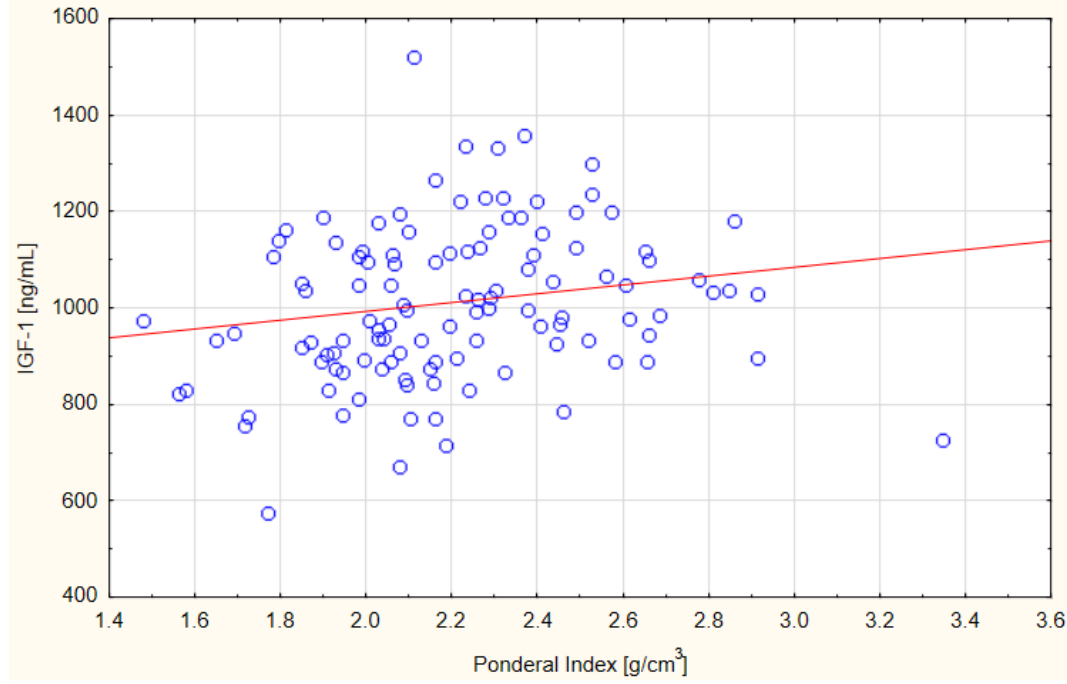
Figure 1. Scatter relationship between PI newborns and insulin-like growth factor 1 (IGF-1) concentration in the blood plasma of women surveyed; Spearman correlation r = 0.26; p = 0.004.